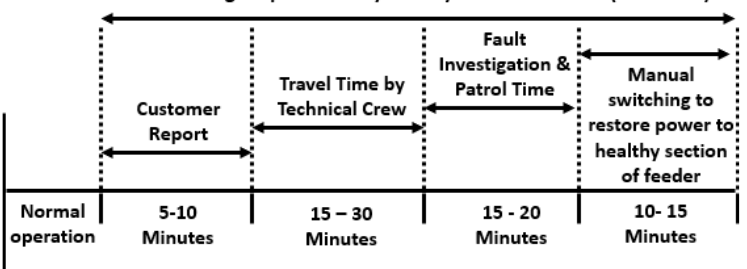
Figure 1. Conventional outage management